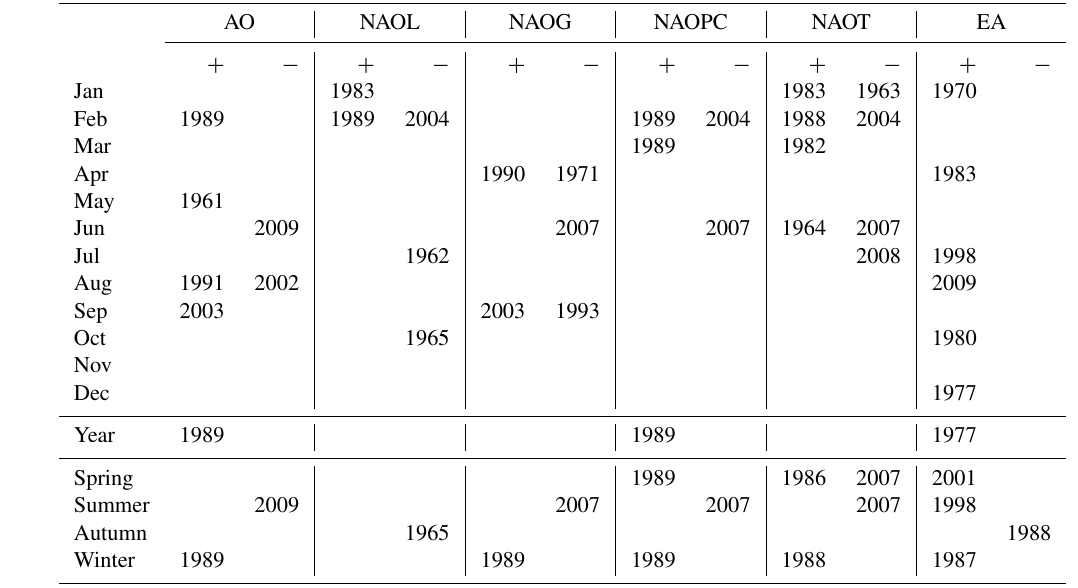
Table 3. Years of statistically significant upward ( + ) and downward ( − ) shifts in time series of the circulation indices from different months and